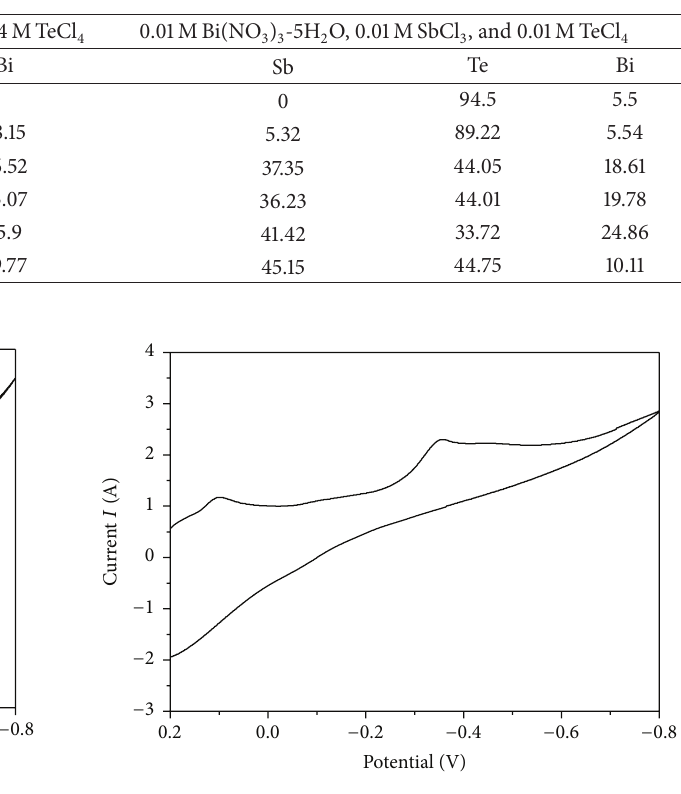
) -5H O and 0.04 MTeCl 3 3 2